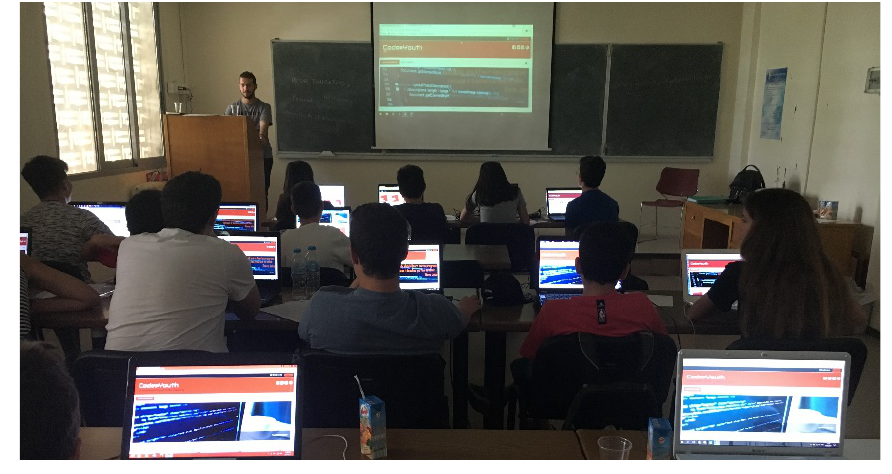
Fig. 1. Students using the